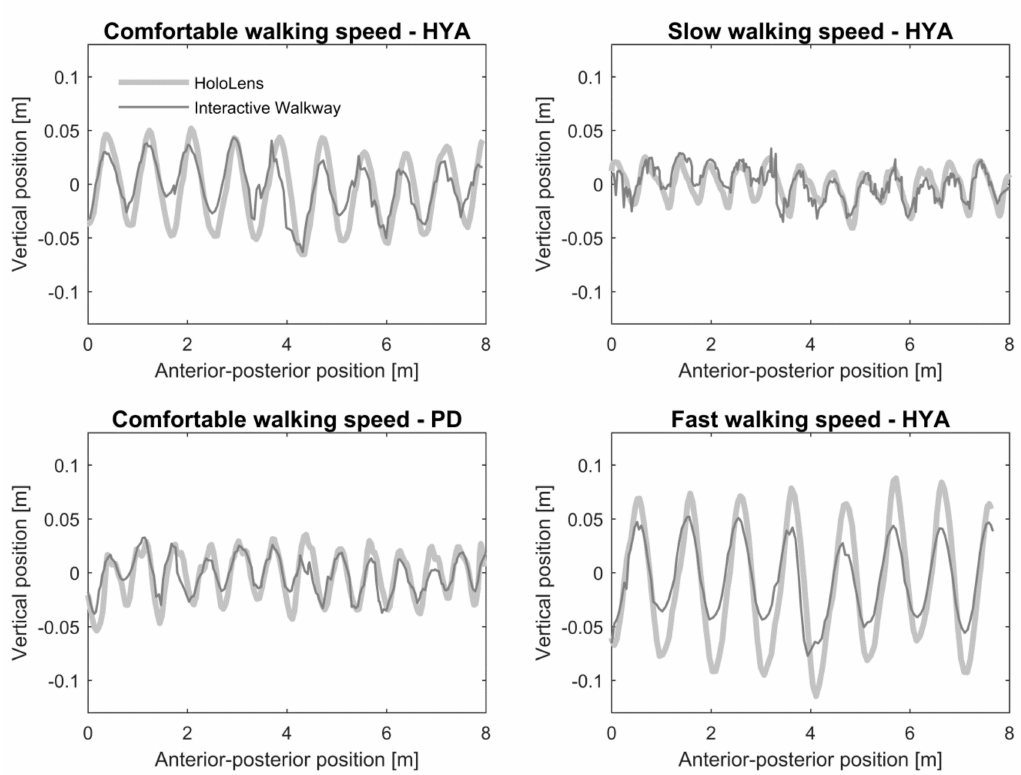
Figure 2. Examples of the position in the anterior-posterior ( x -axis) and vertical ( y -axis) direction for HoloLens’ head data and Interactive Walkway spine shoulder data during slow, comfortable and fast walking speed trials of a healthy young adult (HYA) and for self-selected comfortable walking speed of a person with Parkinson’s disease (PD). The mean was subtracted from the time series in vertical direction for visualization